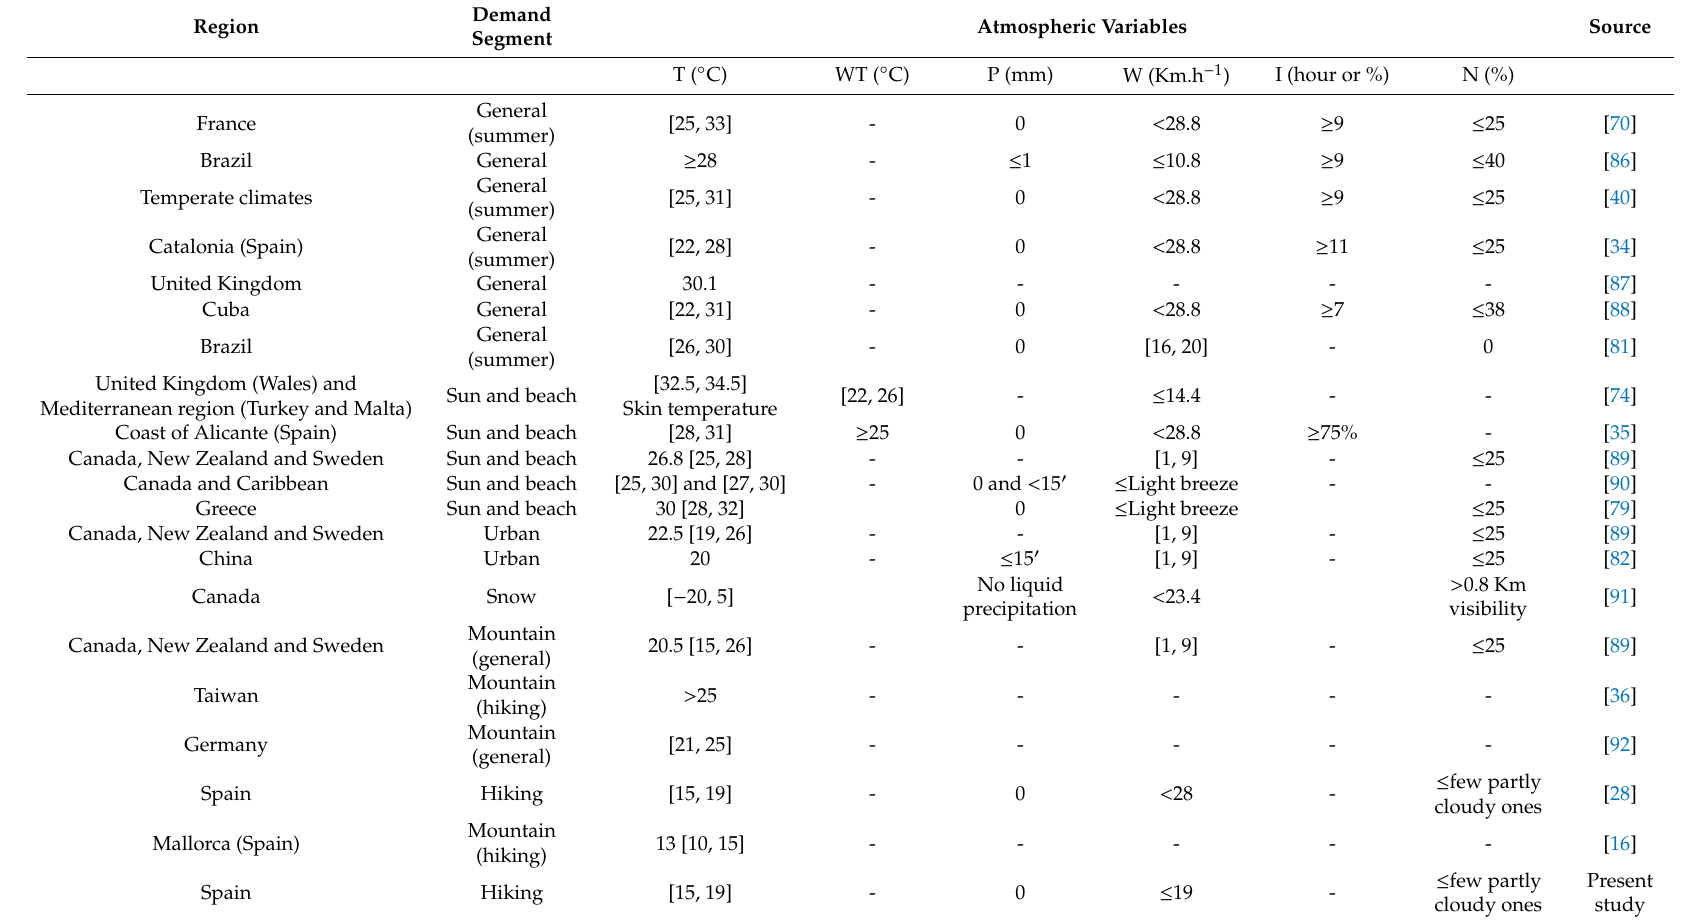
Table 3. Optimum weather conditions for di ff erent daily tourism